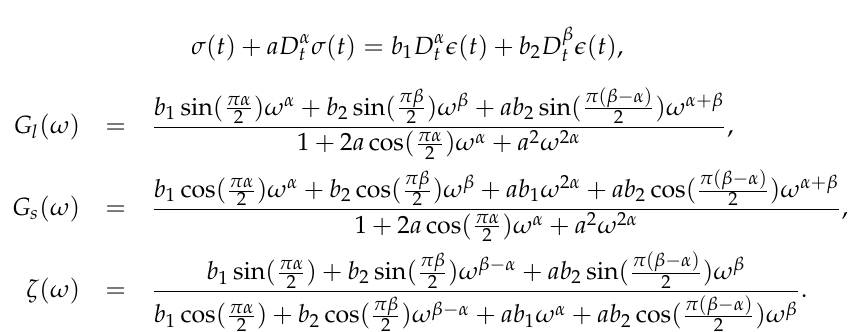
Figure 5. Curves of G s (solid line), G l (dotted line), and ζ (dashed line) versus ω for a = 1, b 2 = 1, α = 0.4, and β = 0.8 in the fractional four-parameter model (61). Fractional five-parameter model ( b 0 =